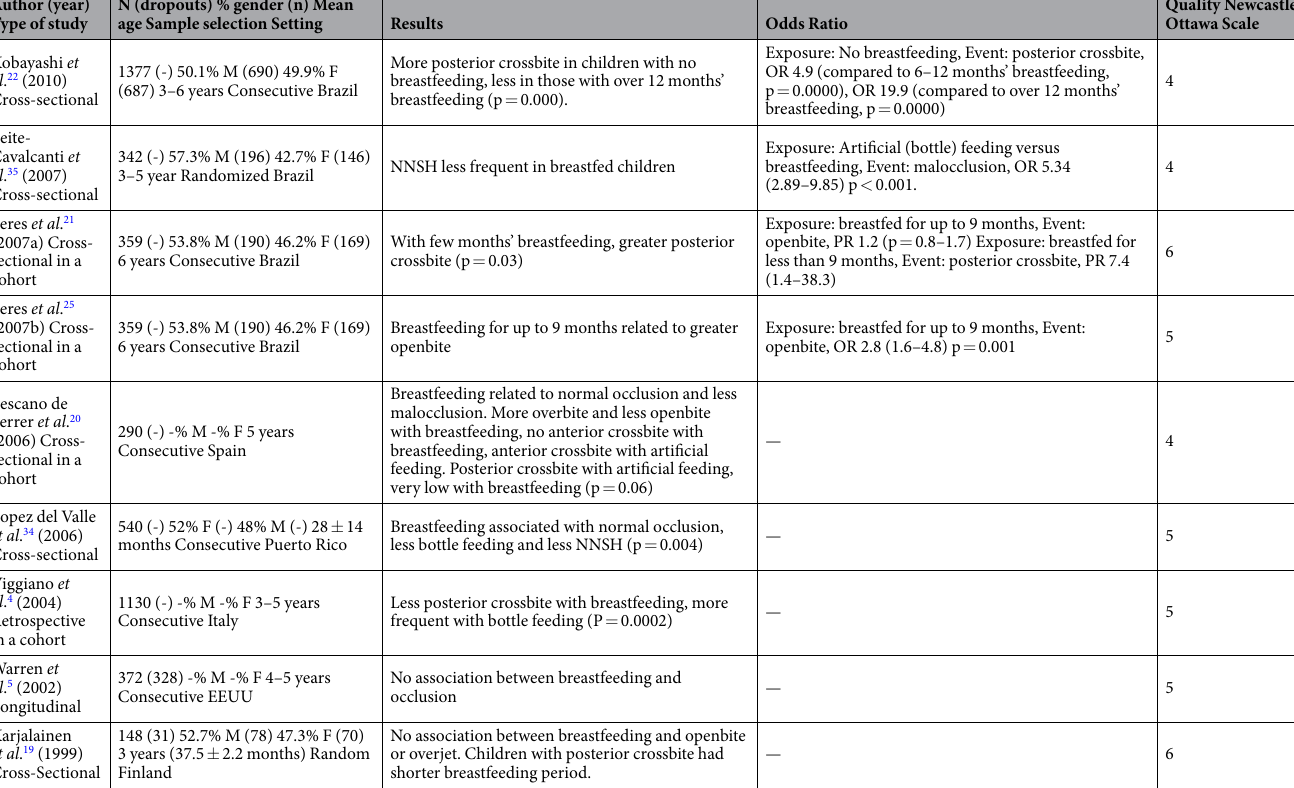
Table 2. Characteristics of articles studying the relationship between breastfeeding and malocclusion in primary dentition. M: male, F: female, OR: odds ratio, CI: confidence interval, PR: prevalence ratio, NNSH: non-nutritive sucking habits, ( − ): no